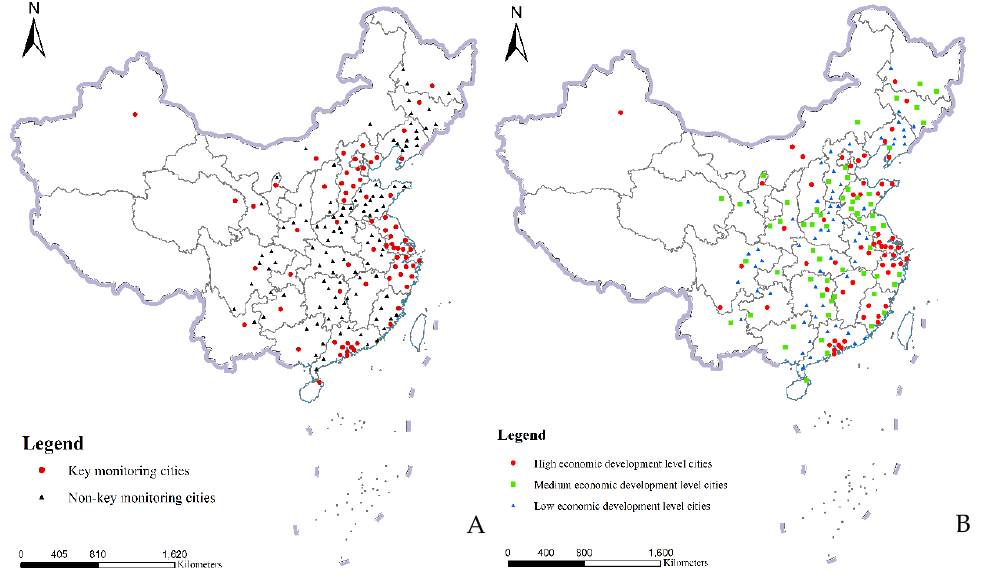
Figure 2. Classification and distribution of research subjects, as grouped by environmental regulation intensity ( A ) or by economic development level ( B ).